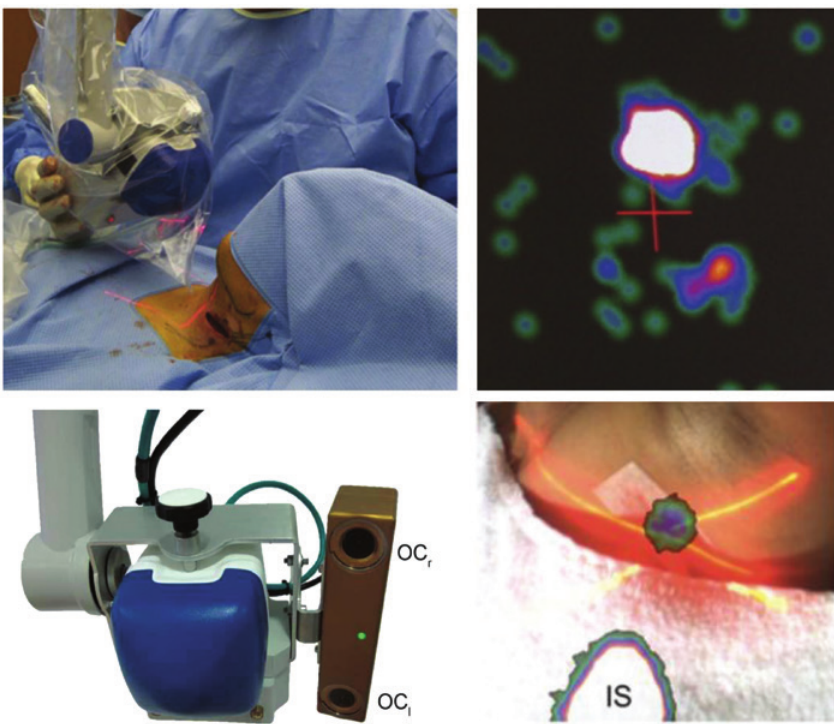
Figure 7: Optical images help surgeons to better localize SLNs in patients. The laser pointer can work as a reference to localize the center of FOV in the image and patient (top). Reproduced with permission from [92]. Optical cameras mounted beside commercial systems can be used to overlay both images on display using image processing methods (bottom). Reproduced with permission from [34,